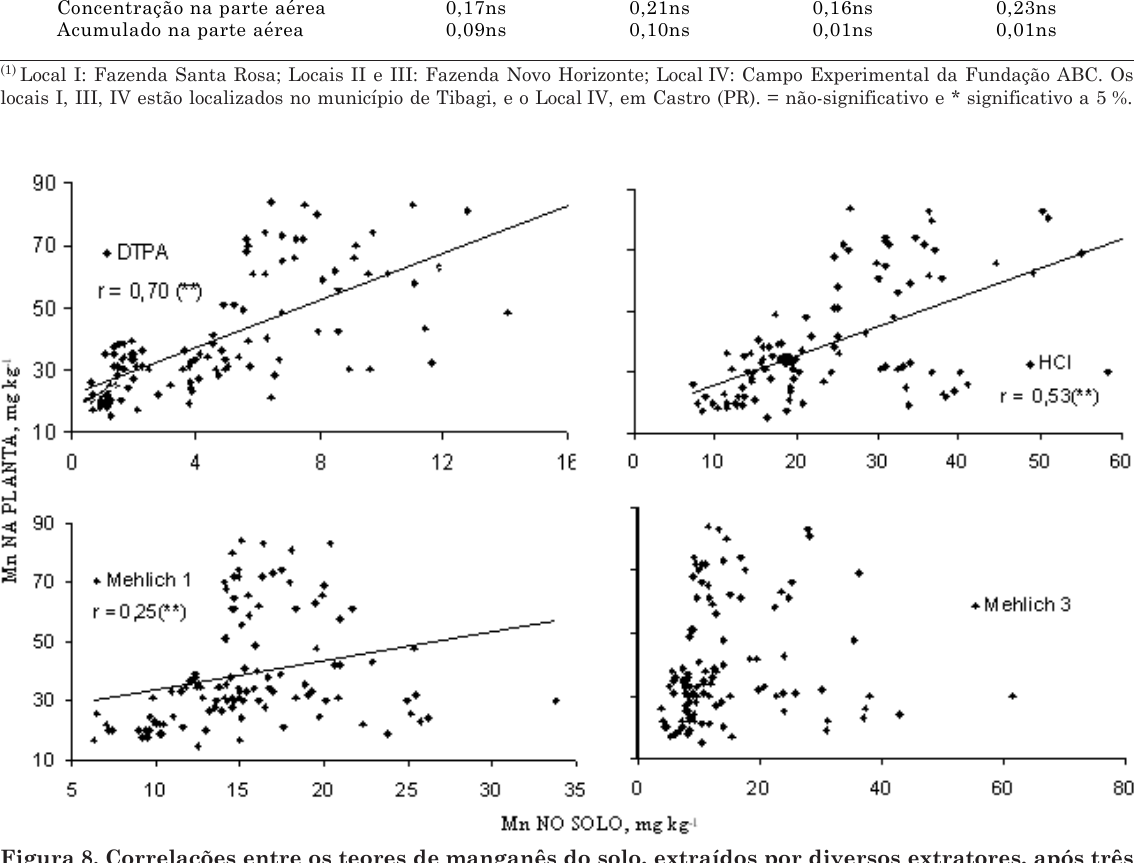
doses em nenhum dos locais (Figura 9).